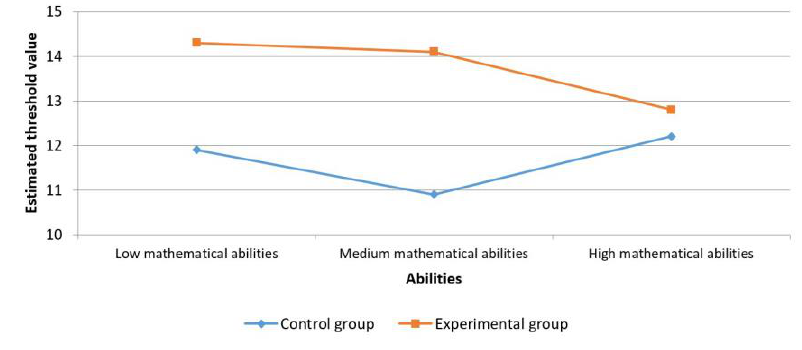
Fig. 3. Estimated Post-Test Threshold